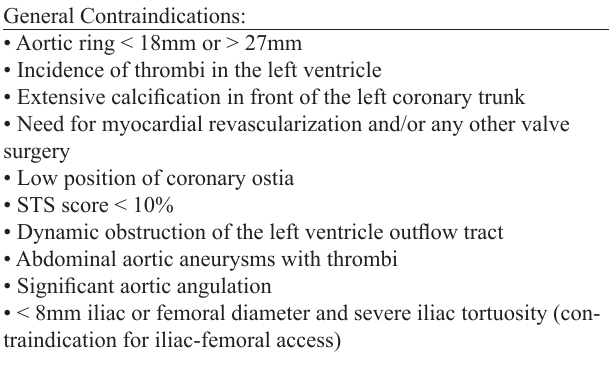
Table 2. Contraindication criteria for transcatheter aortic valve implantation.